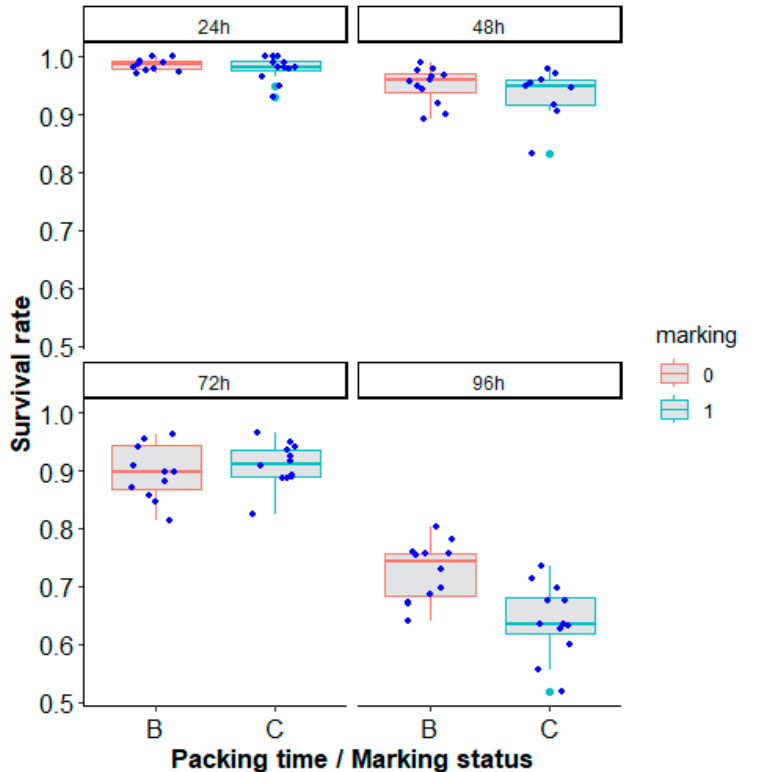
Figure 8. Survival rate (recovery rate) according to marking status (B or 0 = unmarked, C or 1 = marked) and packing duration (24 h, 48 h, 72 h and 96 h panels) of Aedes aegypti , Brazil strain, in laboratory conditions. Each blue dot represents a value of the observed survival rate per replicate. Green dots represent outliers.